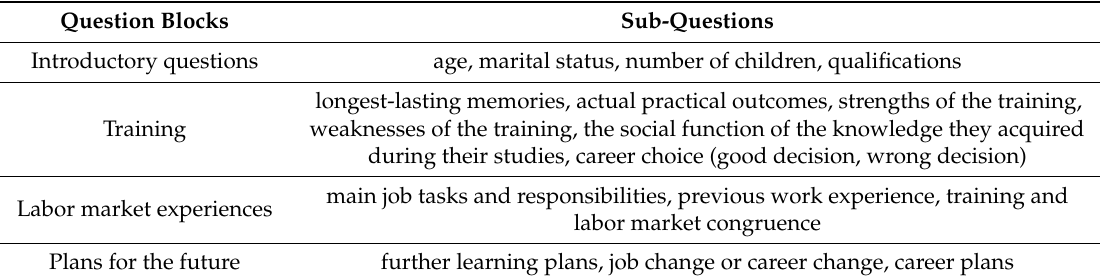
Table 1. Structure of the interview plan.